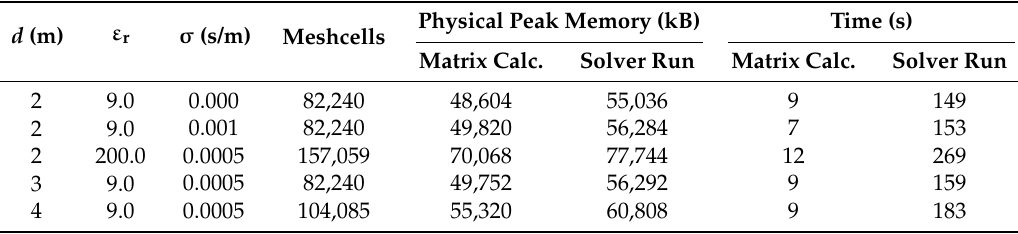
Table 2. Model B1 : Wire embedded in a fictitious dielectric coating. Computational time and memory resources for a 2 d × 2 d m 2 parallelepiped dielectric of ε r .